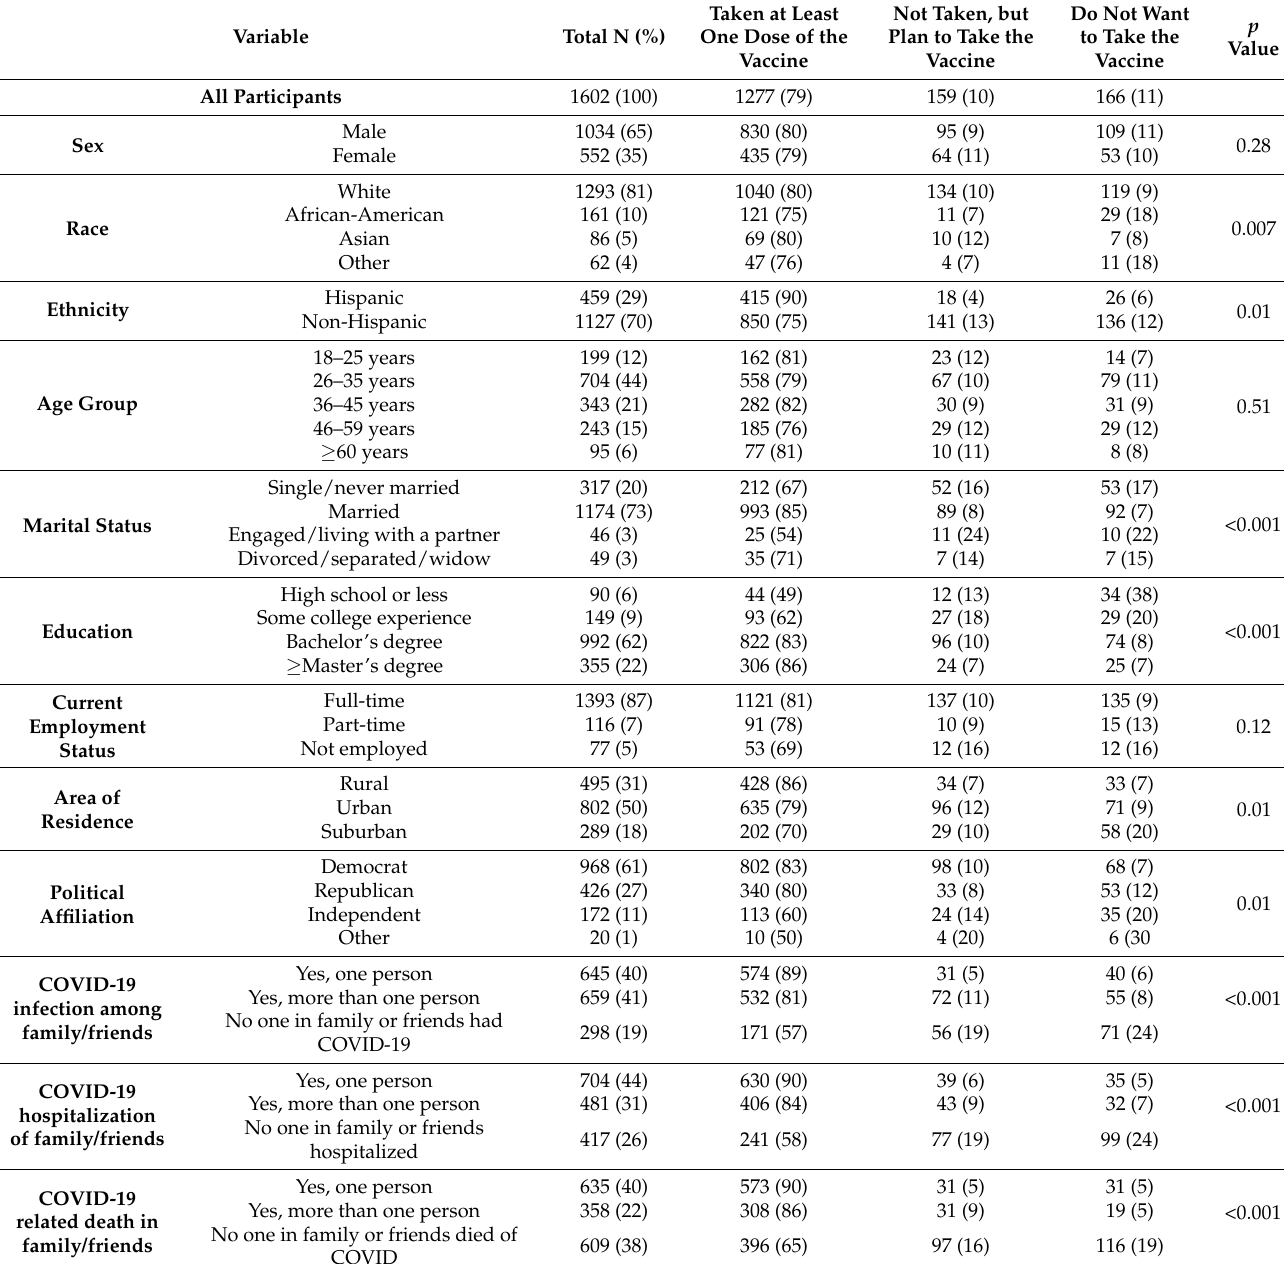
Table 1. Demographic Characteristics, COVID-19 Infection in Social Networks, and Vaccine Willingness